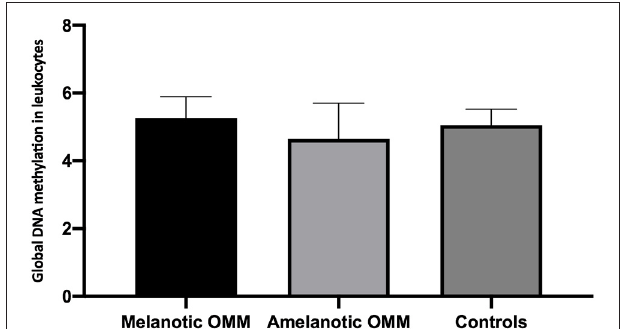
FIGURE 4 | Quantification of global DNA methylation in peripheral blood leukocytes from dogs bearing melanotic OMM, amelanotic OMM, or control dogs. No statistical differences were obtained when the means were compared by ANOVA ( p > 0.05).